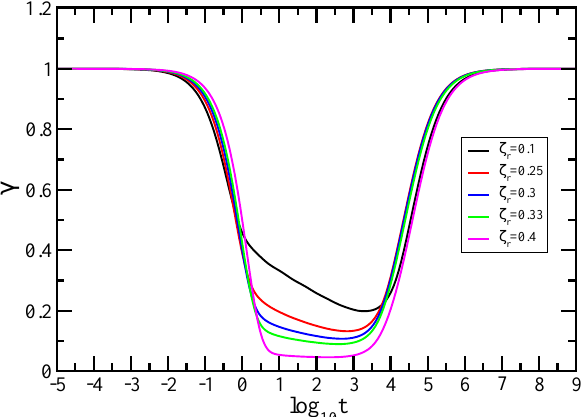
Figure 8. Local slopes γ of the curves of Figure 7. The inset gives the considered values of the hydrodynamic interaction strength. Zimm